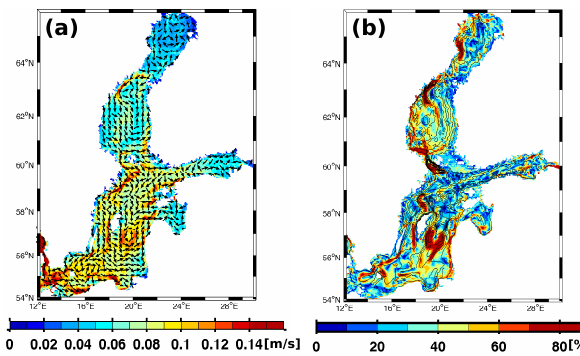
Figure 4. Simulated mean (1987 to 1999) surface circulation. (a) The colour and arrows denote the magnitude and direction of the velocity, respectively. Note that the actual spacial resolution is 20 times higher than indicated by the arrows, both in zonal and meridional direction. (b) shows the persistency R of the surface circulation (in colour, as defined by Eq. 15) along with bathymetry (black contours every 25m). Note that the actual model domain extends further into the North Sea (c.f. Fig. 1 a).